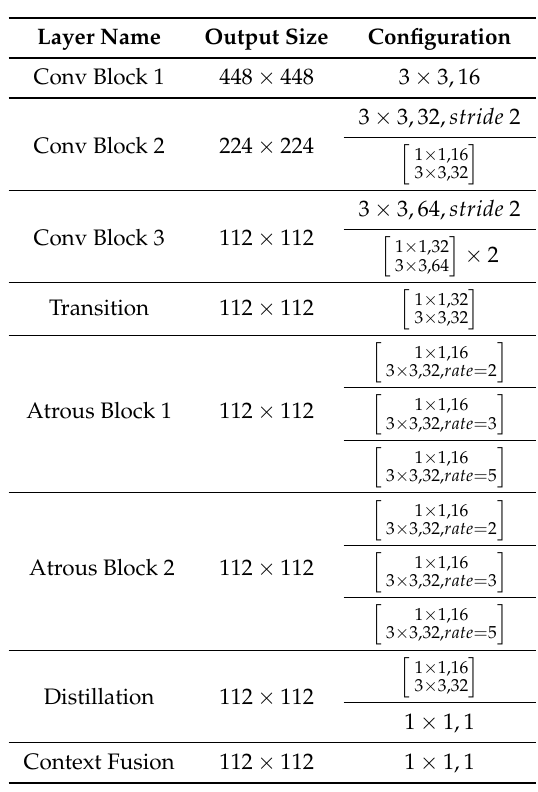
Figure 1. The architecture of the basic unit in our backbone. ( a ) is the layer organization in which a unit is stacked repeatedly and the shortcut connection aids information transfer, and ( b ) is the scheme of the unit, which is composed of a 1 × 1 bottleneck layer and a 3 × 3 ordinary convolutional layer. The compression factor ( α ) and the filters of the Unit ( filters ) jointly determine the number of filters in each layer. Table 1. Configuration of the proposed fully-convolutional network. The parameters in the convolutional layers are denoted as “(kernel size), (number of filters), (stride), (dilation rate)”. Unless otherwise stated, the stride and dilation rate are all set to 1 by